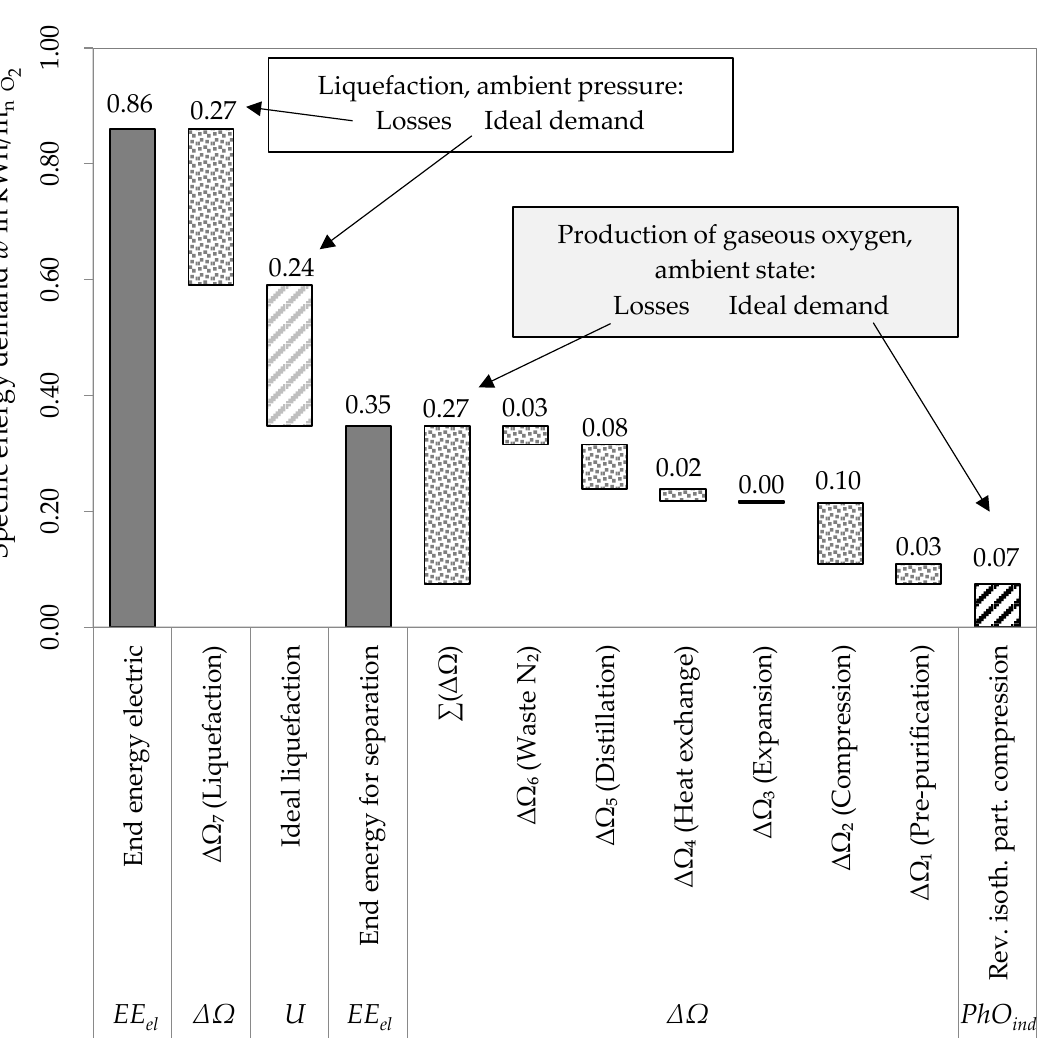
Figure 5. Evaluation of the cryogenic air separation process with the PhO method .